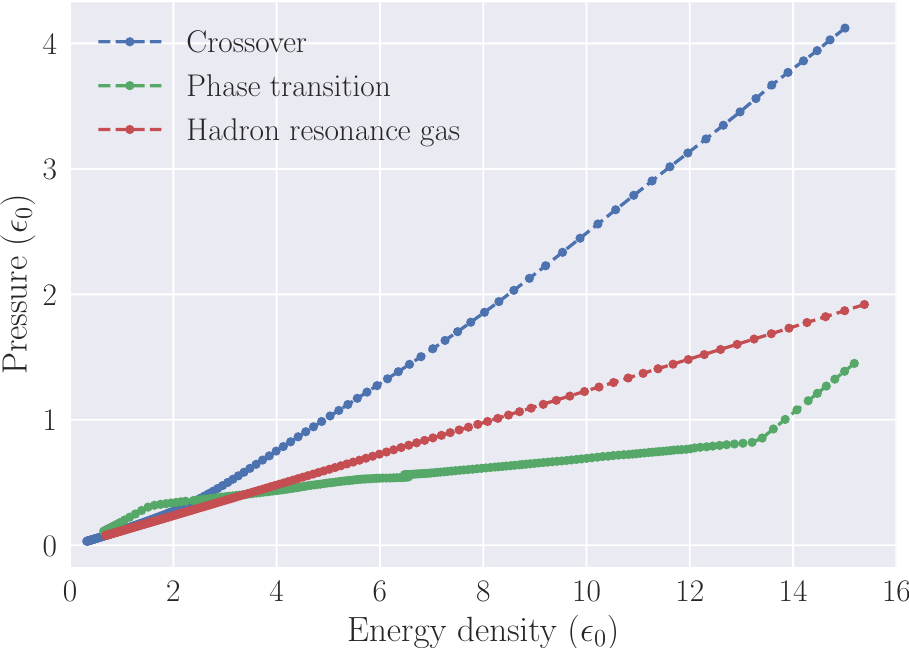
Figure 1 . (Color online) The Equations of State, along an isentropic trajectory, for first order phase transition, crossover transition and hadron resonance gas as incorporated in the simulation. The pressure of the medium for a central cell is plotted as a function of its energy density in central Au-Au collision at 10 A GeV in lab frame. The phase transition is associated with a plateau region where the pressure remains almost constant as the system evolves while the pressure is a continuous function for a crossover transition. The phase transition and crossover EoS are used to train the models while the hadron gas EoS is used only to test the performance of the models on an unseen